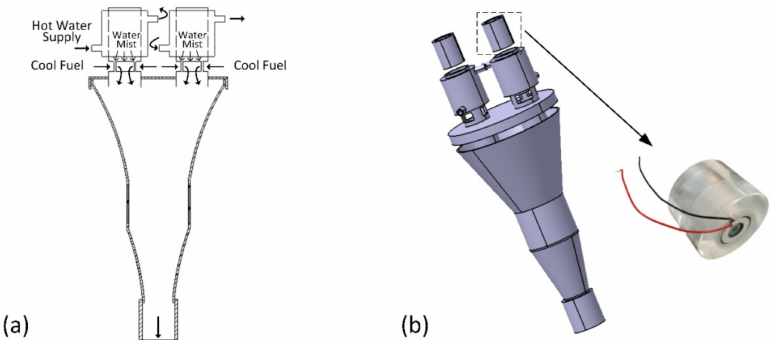
Figure 2. Device for quantitative mixing of water mist and fuel. ( a ) the schematic representation, ( b ) the 3D model.